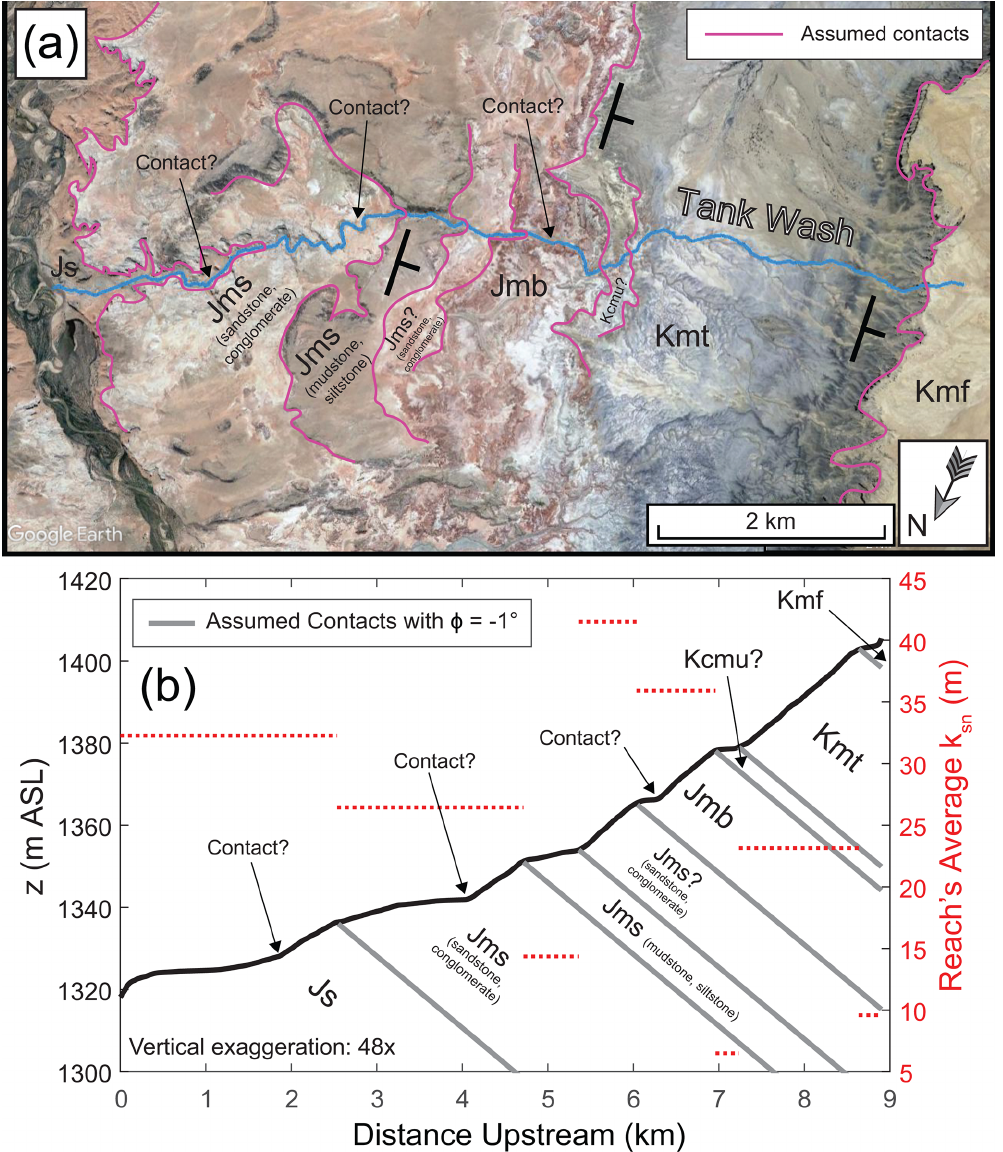
Figure 14. Overview of Tank Wash, a stream near Hanksville, UT. Panel (a) is a Google Earth image (© Google Earth) with the stream and geology shown. Panel (b) is a longitudinal profile for Tank Wash with the assumed contacts from ( a ) shown as gray lines. The average steepness ( k sn ) for each reach situated between these contacts is shown in red. The lithologies are as follows: Kmf is brown sandstone and mudstone; Kmt is gray shale, siltstone, and mudstone; Kcmu and Jmb are color-banded siltstone, claystone, mudstone, and shale; Jms contains both red–brown mudstone and siltstone as well as light-yellow–gray lenticular sandstone and conglomerate; and Js is red–brown siltstone, sandstone, and